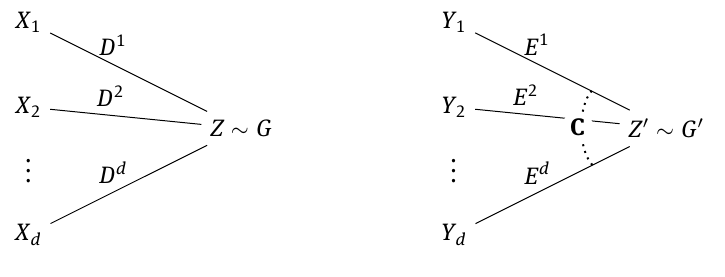
Figure 1 On the left: a partially specified factor model with dependence specifications D 1 , . . . , D d and risk factor distribution function G . On the right: a completely specified factor model with dependence specifications E 1 , . . . , E d , conditional copula family C and factor distribution function G (cid:48)